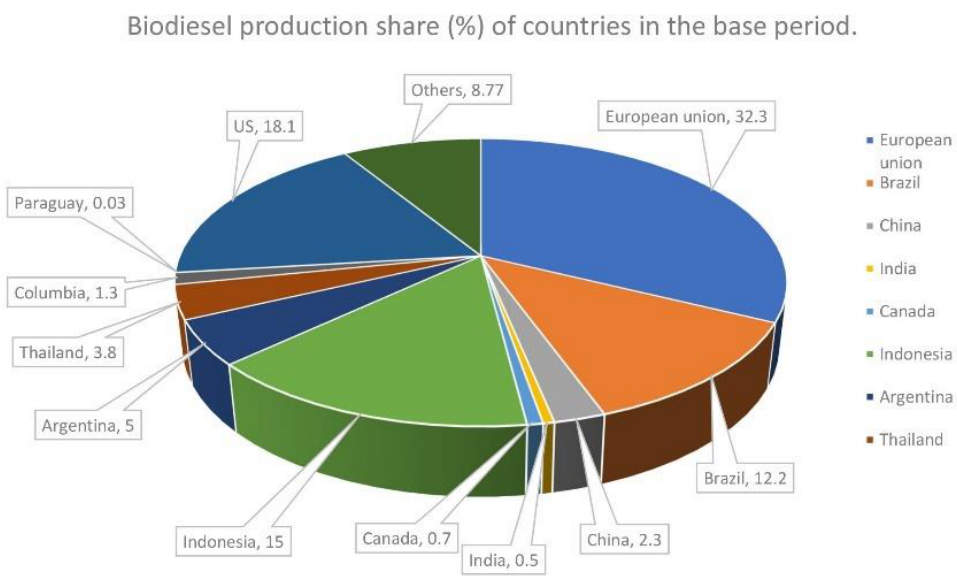
Figure 1. World biodiesel production, 2021 (percentage refers to production share of countries in the base period). Data adapted from [9], open access journal of Sustainability, 2021.